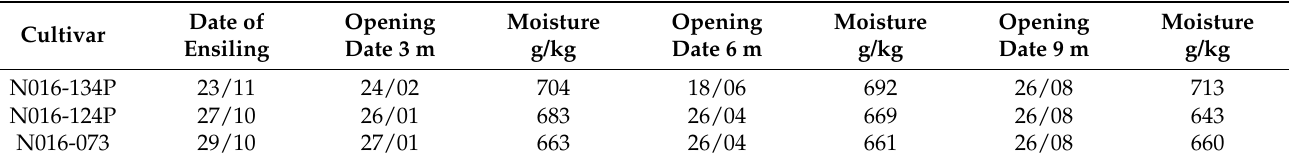
Table 1. Description of the maize crop samples and dates of ensiling (2020) and opening (2021) of